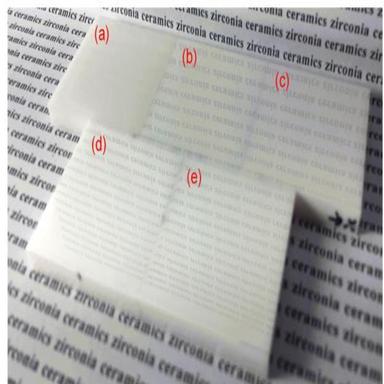
Appearance of the Y-TZP samples before and after polishing under different tool offsets: (a) initial surface; (b) 0.04 mm; (c) 0.06 mm; (d) 0.08 mm; (e) 0.1 mm.